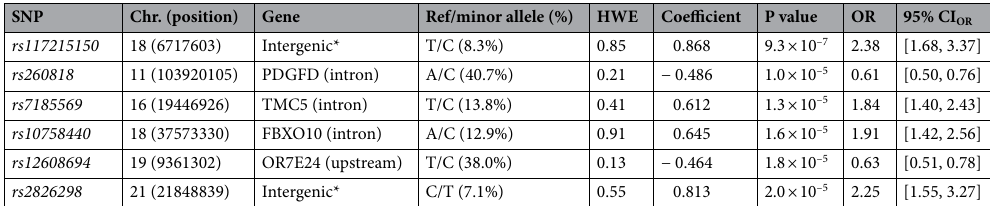
SNP Chr. (position) Gene Ref/minor allele (%) HWE Coefficient P value